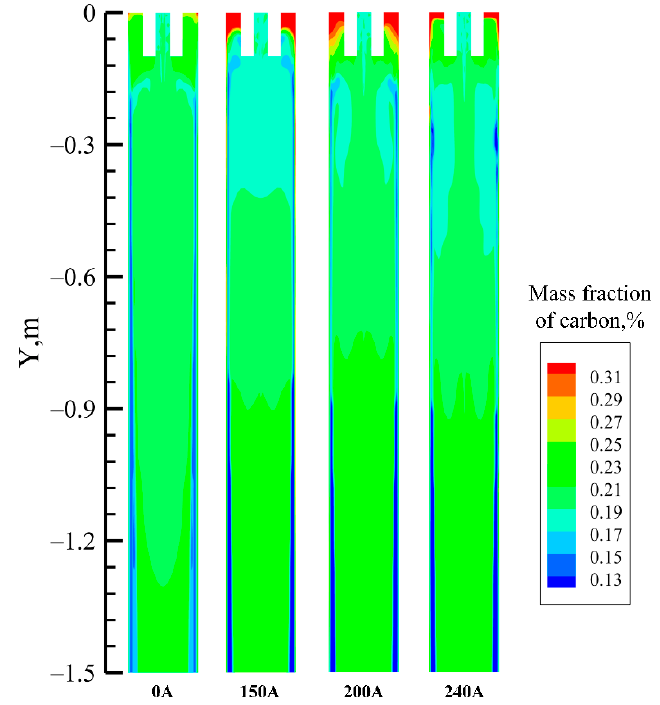
Figure 10. The carbon concentration field in the continuous casting mold with M ‐ EMS.